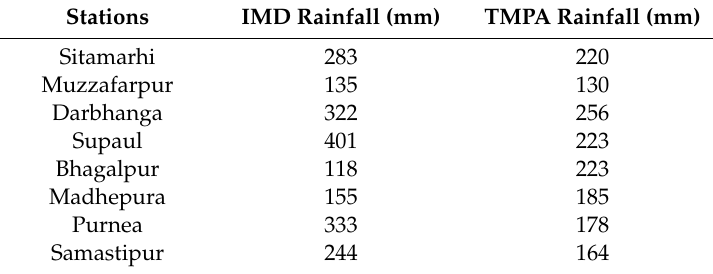
Table 2. Rain gauge station wise accumulated rainfall (mm) over the period of 10 to 16th August, 2017 as derived from TMPA and observed from